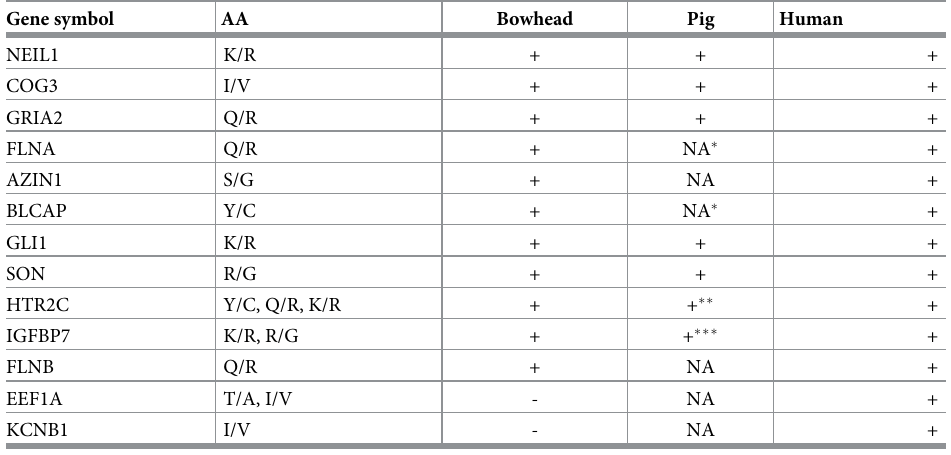
Table 1. Conservation of A-to-I recoding editing sites in bowhead, pig and human. AA, amino acid